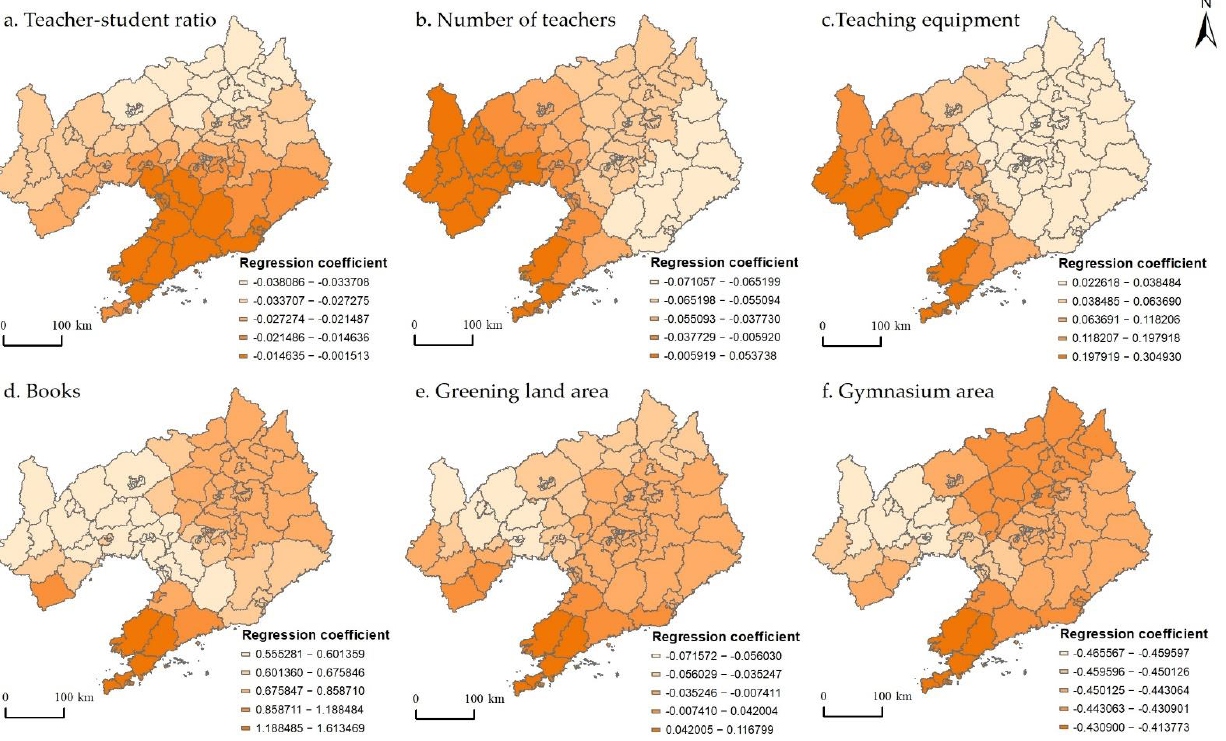
Figure 5. Spatial distribution of regression coefficients in the GTWR model in 2020: ( a ) teacher-student ratio, ( b ) number of teachers, ( c ) monetary value of teaching equipment, ( d ) number of books, ( e ) area of green spaces and ( f ) area of gym- nasiums.